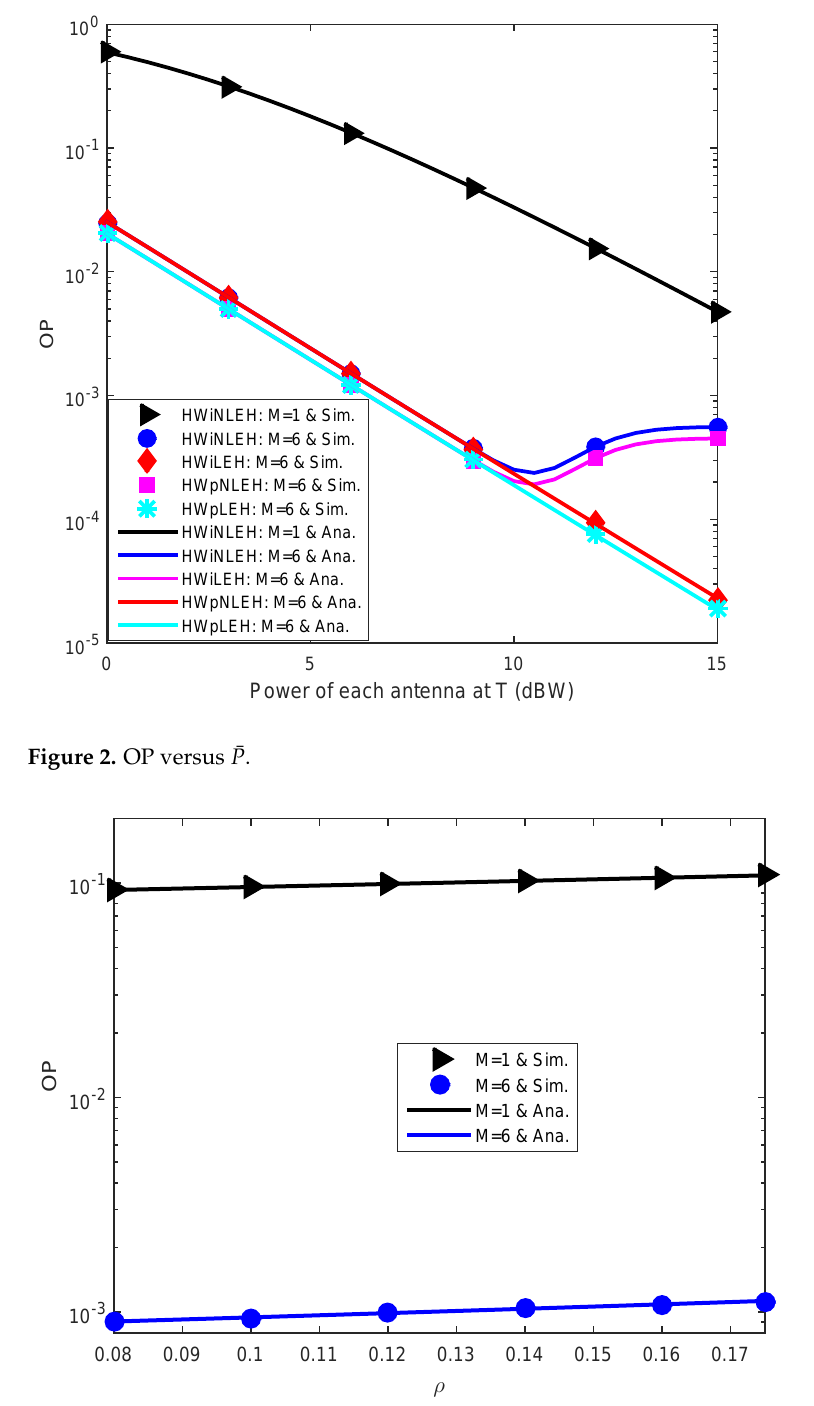
Figure 3. OP versus the HWi degree ρ